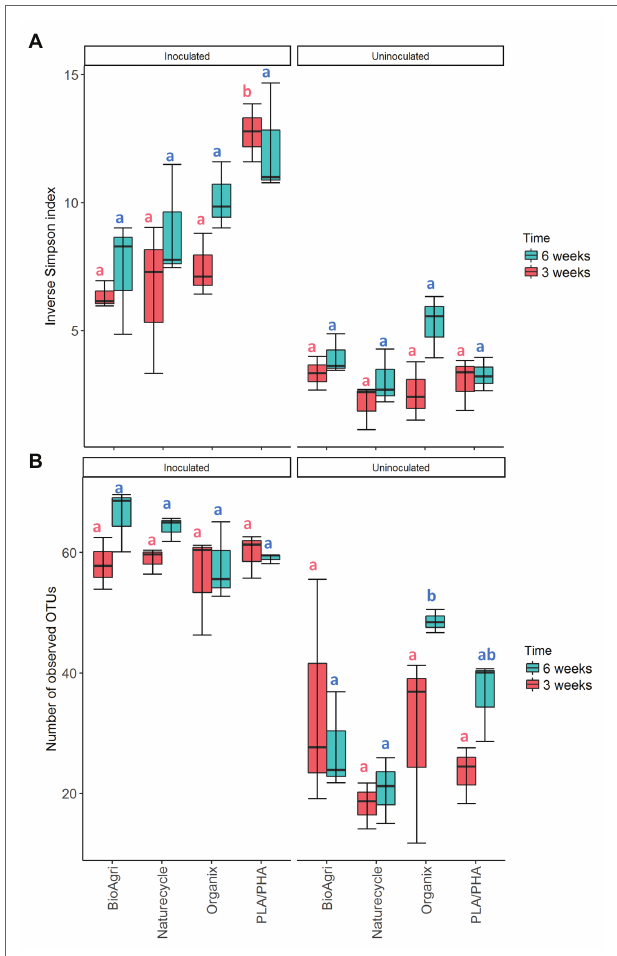
FIGURE 3 | (A) Bacterial taxa distribution (class level) on biodegradable plastic mulch films (BDMs) in laboratory enrichment cultures. Mean relative abundances above a cut-off level of 2% are indicated. “Bacteria unclassified” denote taxa with relative abundances above the cut-off level of 2%, but that could not be classified. (B) Non-metric multidimensional scaling (NMDS) ordination of bacterial communities on inoculated BDMs. Time refers to incubation time; treatments are four different biodegradable mulch films. NMDS stress value: 0.24.